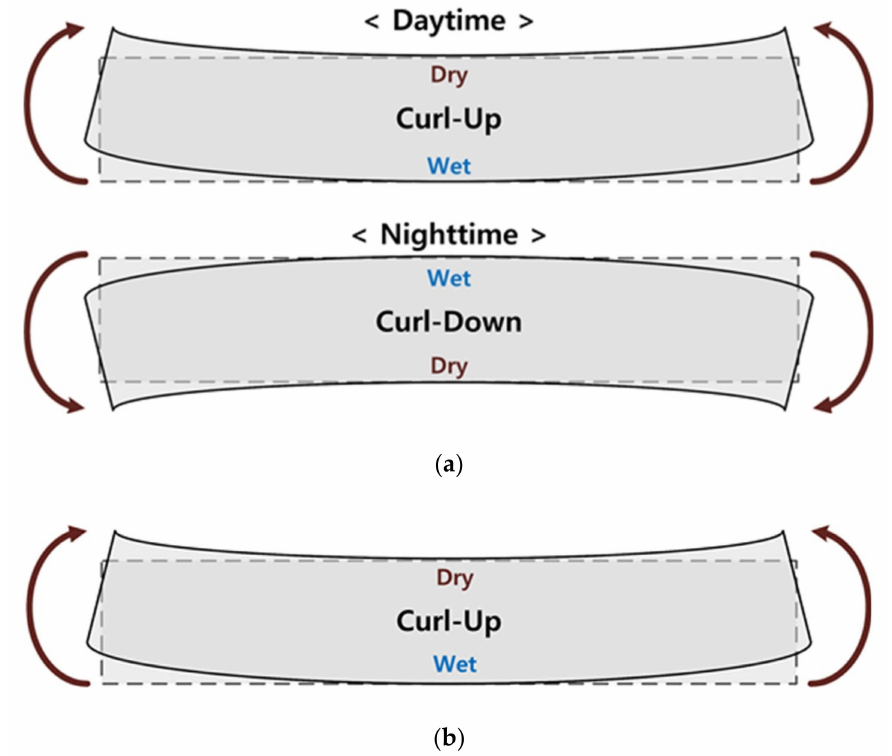
Figure 15. Early age behavior of concrete slab estimated by the shrinkage strain: ( a ) due to daily humidity variation and ( b ) due to di ff erential drying shrinkage between top and bottom of